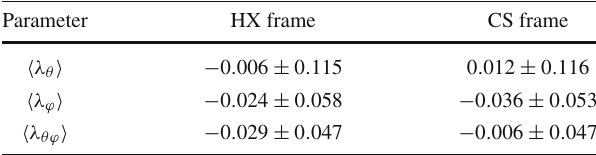
Table 4 Average p T -integrated (over 2 < p T < 15 GeV / c in the rapidity range 2 . 5 < y < 4 . 0) inclusive J/ ψ polarization parameters (cid:7)